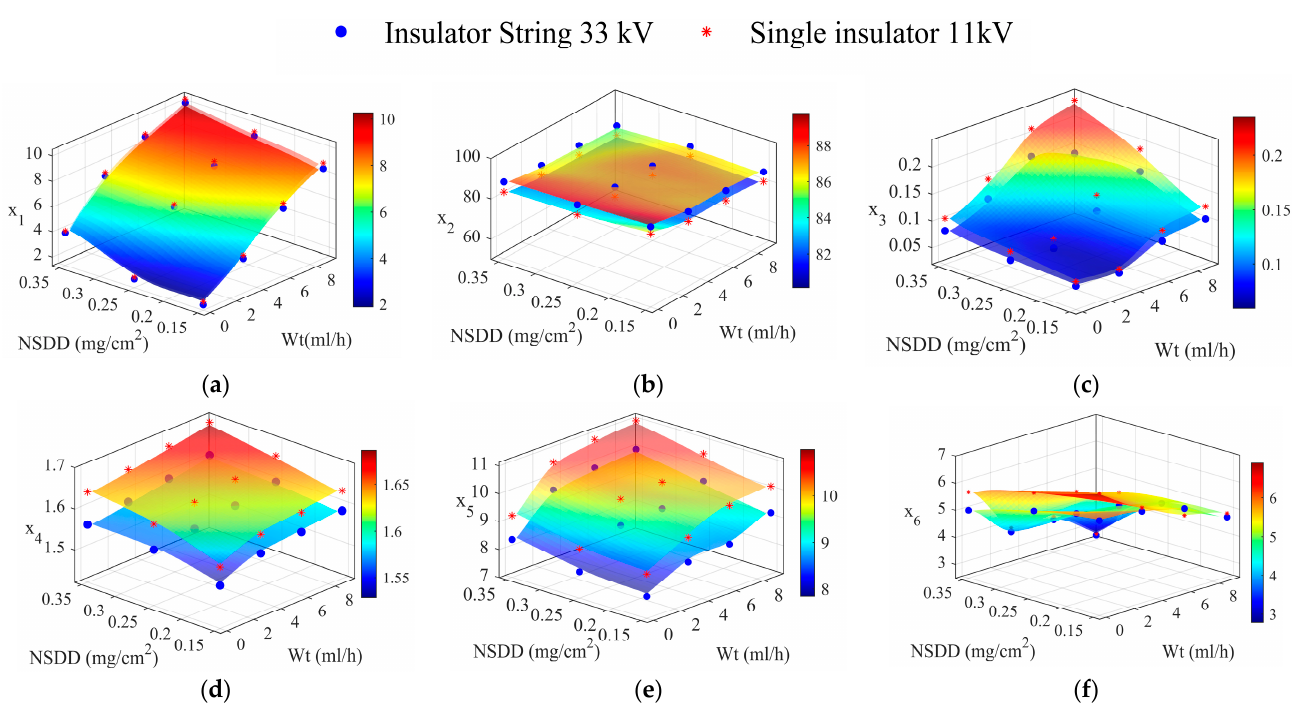
Figure 9. LC indices of a clean insulator under different Wt and NSDD; ( a ) x 1 ; ( b ) x 2 ; ( c ) x 3 ; ( d ) x 4 ; ( e ) x 5 ; ( f ) x 6 .